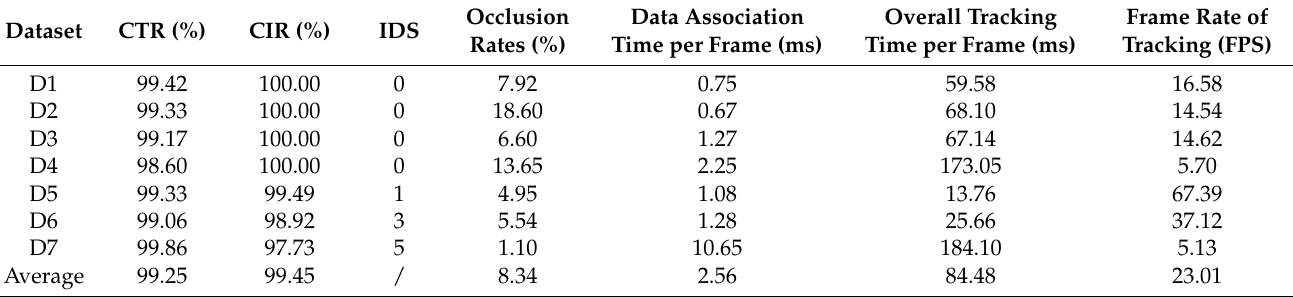
Table 3. Tracking performance analysis of the proposed tracking